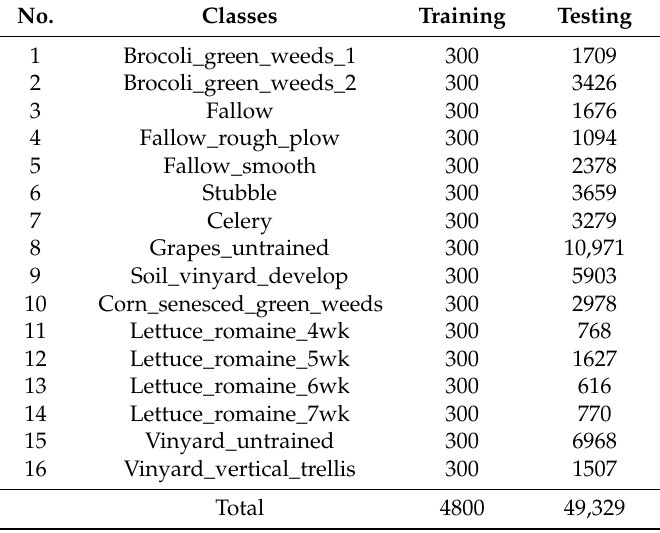
Table 4. Number of training and testing samples used in the Salinas